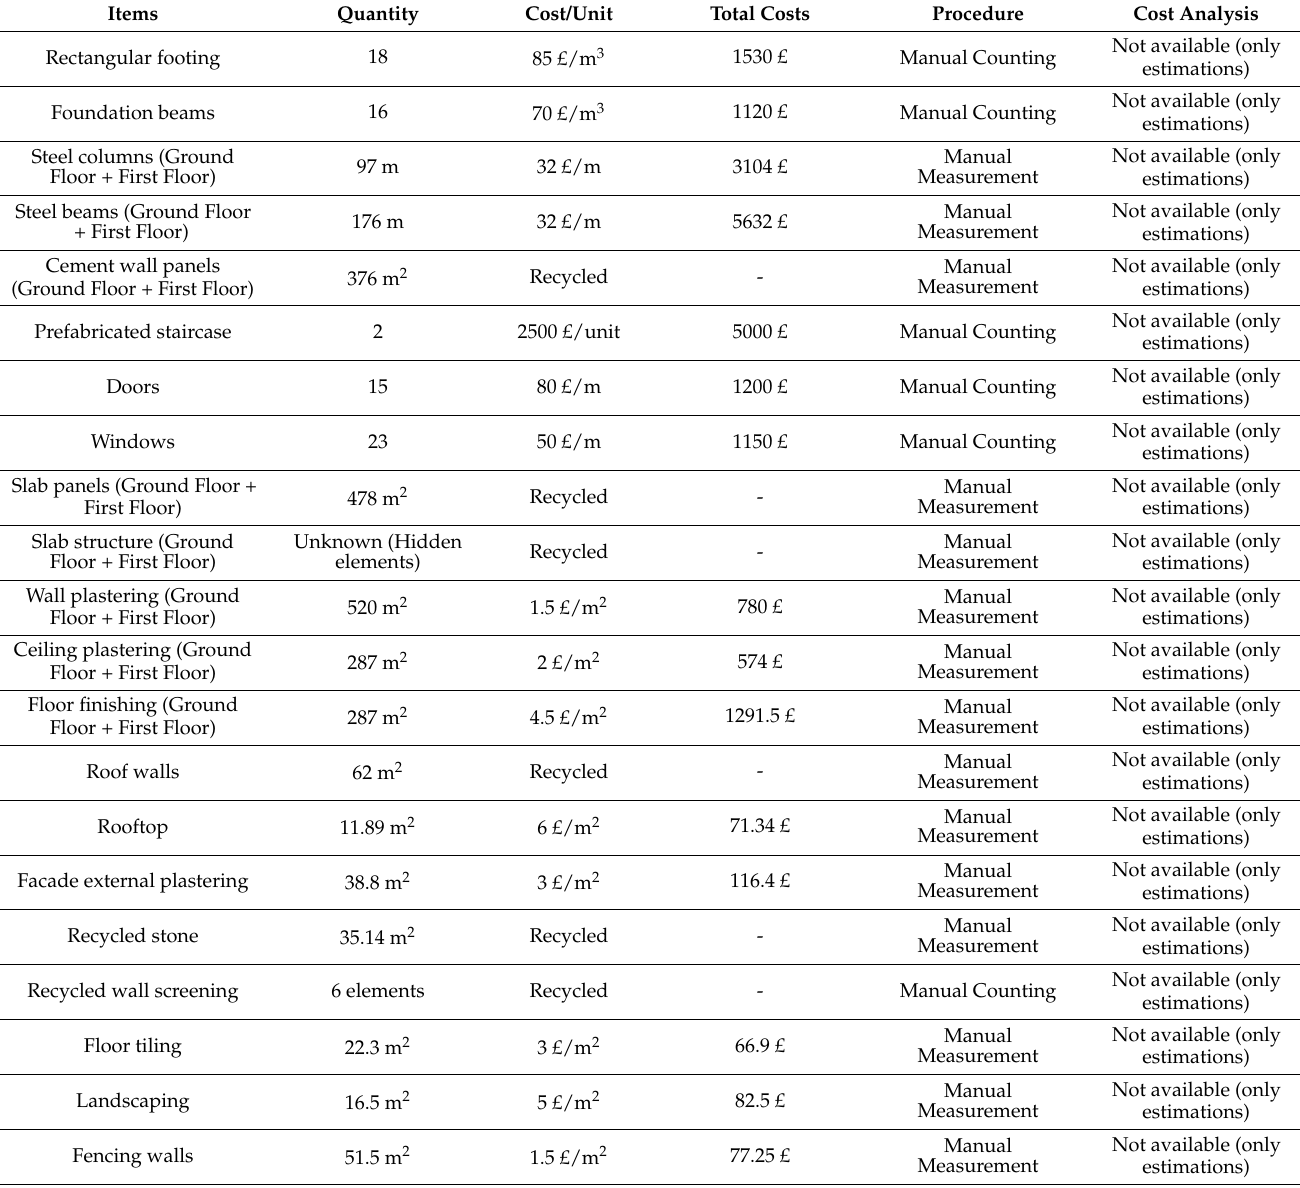
Table 5. Construction cost estimation using Conventional Method in